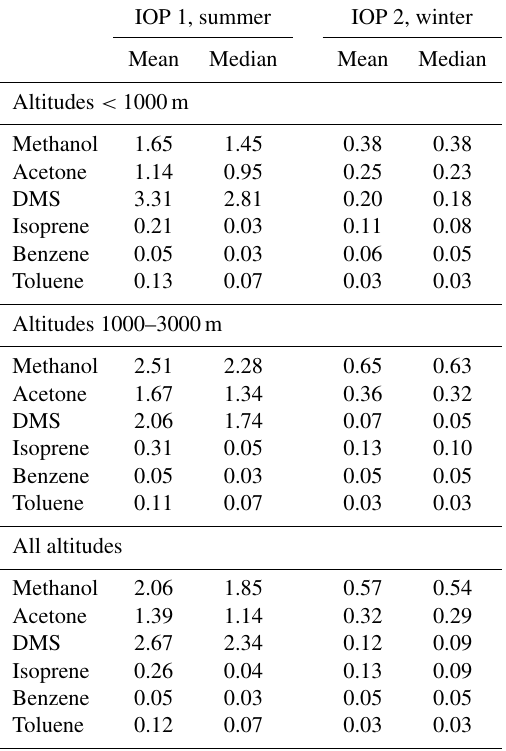
Table 2. Summary of PTR-MS measurements aboard the G-1 dur- ing